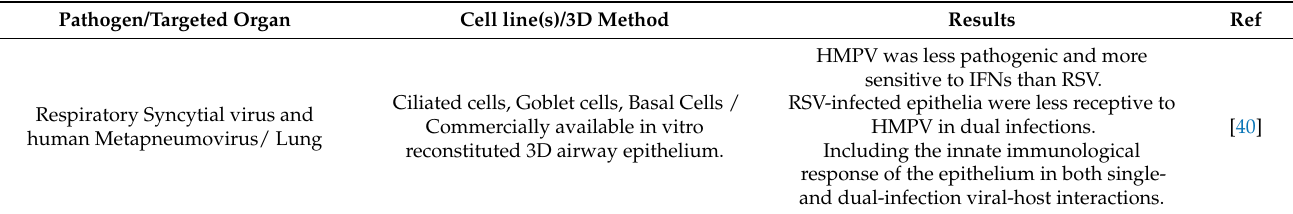
Table 1. Selected studies of three-dimensional cell culture and emphasized